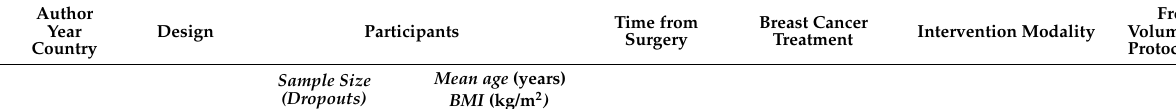
Table 2. Main characteristics of the studies